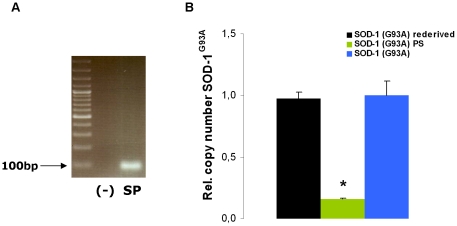
The SOD-1 (G93A) transgene in the SOD-1 (G93A)PS line.(A) Genotyping of the SOD-1 (G93A)PS mouse reveals a characteristic band from the SOD-1 (G93A) transgene. (B) Copy number of the SOD-1G93A transgene is reduced in the SOD-1 (G93A)PS mice by a factor of 6 when compared to normal SOD-1 (G93A) mice, littermates from the first SOD-1 (G93A)PS mouse or from newly rederived SOD-1 (G93A) mice (p<0.05).